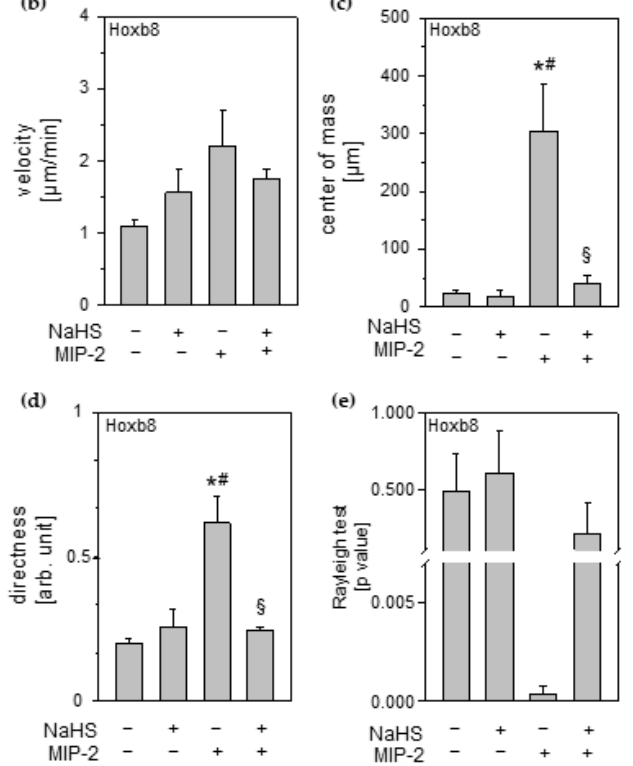
Figure 6. Effect of hydrogen sulfide on neutrophil chemotaxis Hoxb8 neutrophils were attracted with MIP-2 and treated with 1 mM NaHS, as indicated. The migration behavior of neutrophils was determined. ( a ) Representative trajectory plots: Starting points are set to zero and last tracking position marked with a black dot; the blue dot indicates the center of mass (average end position of tracked cells). Analysis of ( b ) velocity, ( c ) center of mass, ( d ) directness, and ( e ) Rayleigh test for the entire chemotaxis experiment. Data represent means ± SEM for n = 3/group. Analysis of variance (Tukey’s post hoc test), * p < 0.05 vs. control; # p < 0.05 vs. control + NaHS; § p < 0.05 vs.